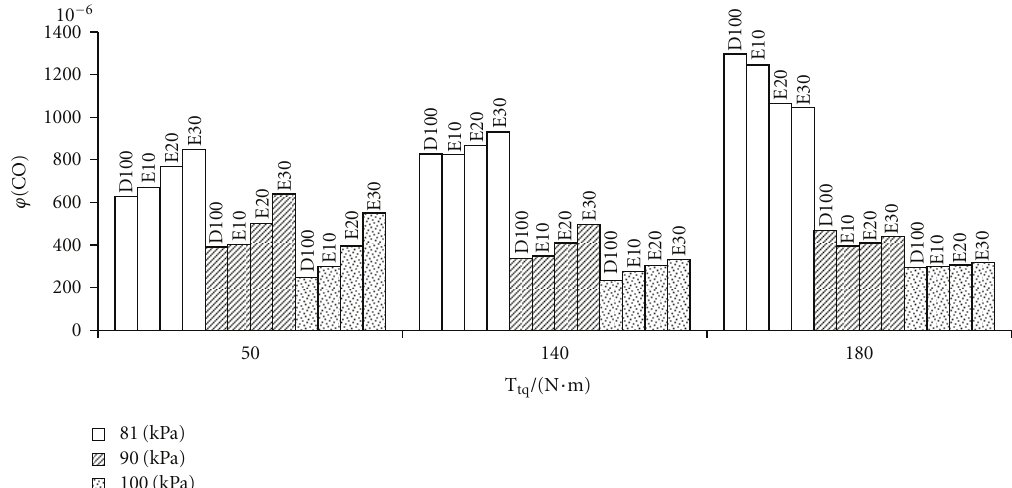
Figure 5: Comparison of CO emission of di ff erent atmospheric pressure and mix proportion at speed